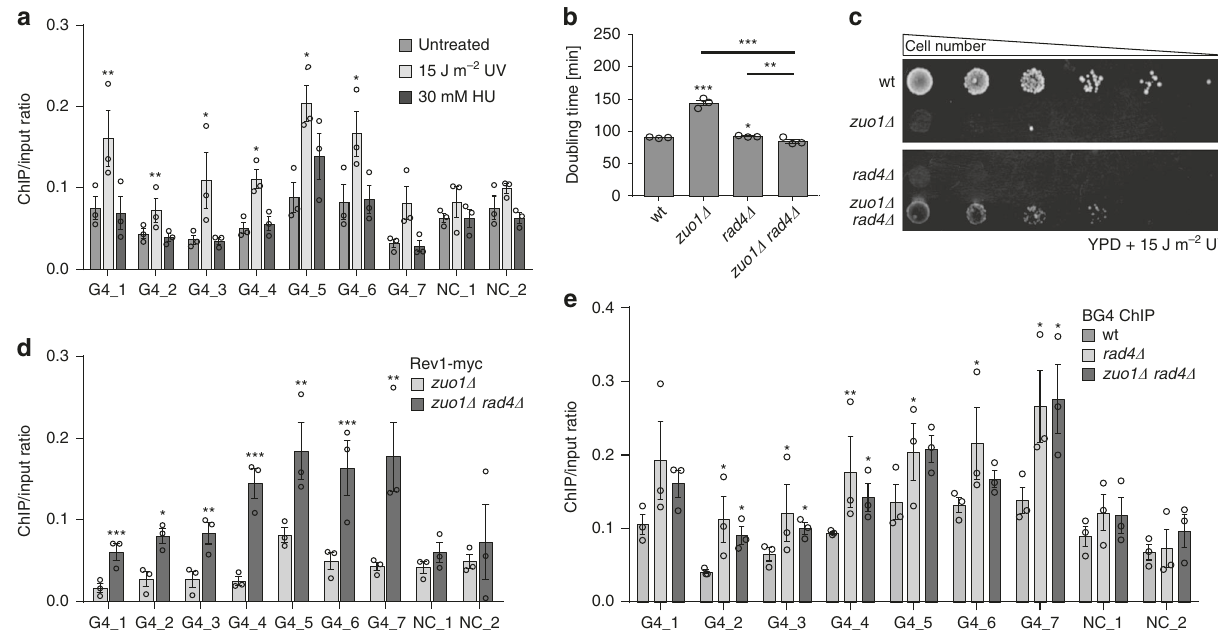
Fig. 5 Zuo1 de fi ciency and NER impairment increase TLS activity at G4 sites. a BG4-ChIP analysis followed by qPCR of G4 levels in untreated wildtype, treated with J m − 2 UV (254 nm) and 30 mM HU strains. Plotted are the means of n = 3 biologically independent experiments. Error bars present ±SEM. Signi fi cance was calculated based on one-sided Student ’ s t -test. Asterisks indicate statistical signi fi cance: * p < 0.05, ** p < 0.01, *** p < 0.001. b Growth curves of indicated yeast strains in liquid media. Doubling times (minu) were calculated. Plotted are the means of n = 3 biologically independent experiments. Error bars present ±SEM. Signi fi cance was calculated based on one-sided Student ’ s t -test. Asterisks indicate statistical signi fi cance: * p < 0.05, ** p < 0.01, *** p < 0.001. c Different concentrations of yeast cells were spotted on rich media, with or without irradiation with 15 J m − 2 UV light (254 nm). Growth changes and sensitivity were monitored by colony formation. d Rev1 Myc-ChIP analysis followed by qPCR to test Rev1 binding at nine different loci. The bars show the IP value over the input of the zuo1 Δ strain as well as the double mutant zuo1 Δ rad4 Δ . Plotted are the means of n = three biologically independent experiments. Error bars present ±SEM. Signi fi cance was calculated based on one-sided Student ’ s t -test. Asterisks indicate statistical signi fi cance: * p < 0.05, ** p < 0.01, *** p < 0.001. e BG4-ChIP analysis followed by qPCR of G4 levels in wildtype, rad4 Δ and zuo1 Δ rad4 Δ strains. Plotted results are the means of n = 3 biologically independent experiments. Error bars present ±SEM. Signi fi cance was calculated based on one-sided Student ’ s t -test. Asterisks indicate statistical signi fi cance in comparison with wildtype: * p < 0.05, ** p < 0.01, *** p <